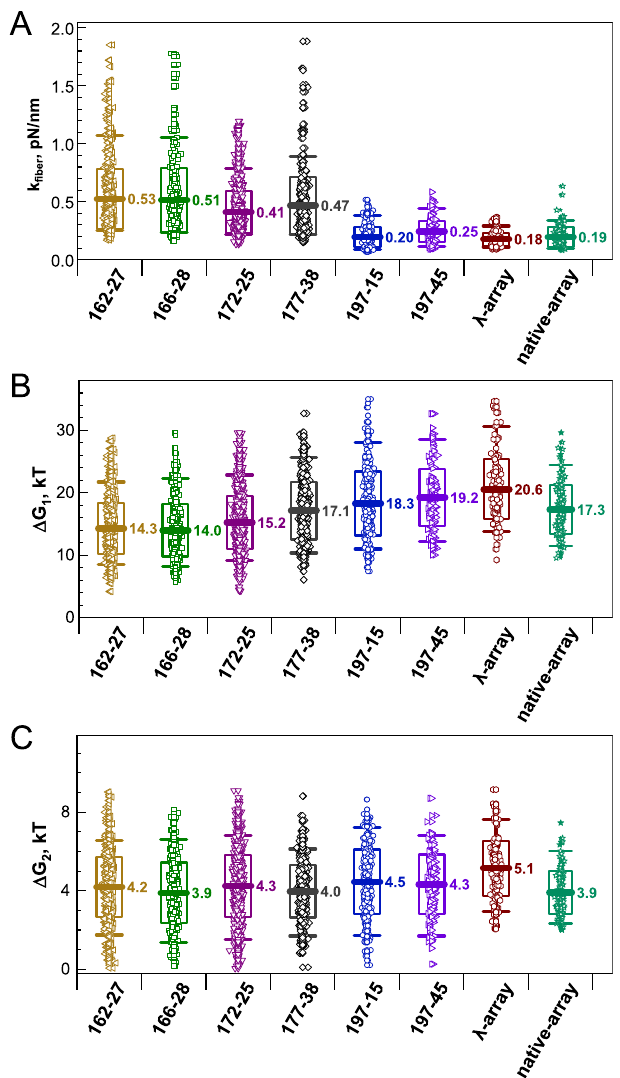
Figure 7. Summary of the mechanical parameters determined for the arrays studied in this work. Nucleosome array ( A ) stiffness ( k fiber ; the first stage of pulling), free energies of ( B ) the second ( ∆G 1 ) and ( C ) third ( ∆G 2 ) stages of the array pulling. For the arrays reconstituted on the ‘601’ positioning DNA, the nucleosome repeat length and number of the repeats are indicated on the x-axis. Mean values of the respective parameters are displayed in the graphs. Boxes show the range within the mean ± sd; whiskers show the range from 5 to 95% around the median value. OriginPro software 75 (http:// www. origi nlab. com) was used to create the